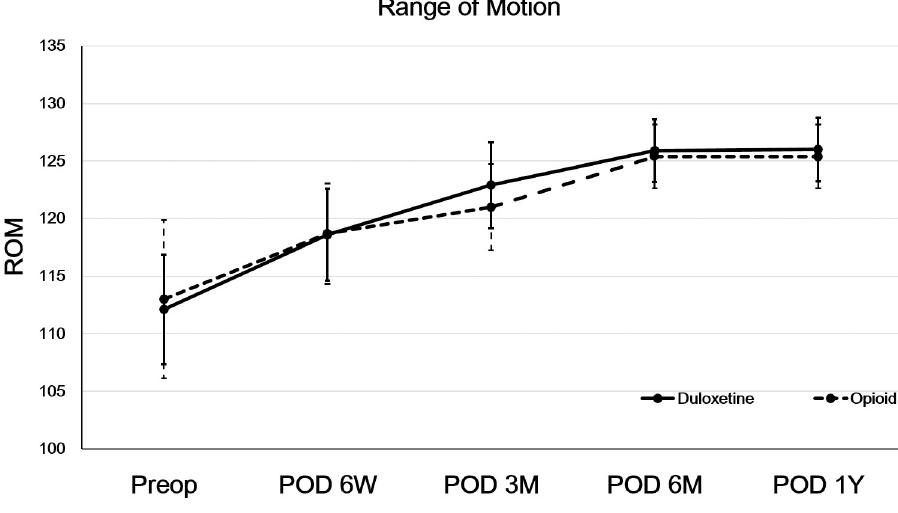
Fig 2. Comparisons of Range of Motion (ROM) between duloxetine and opioid groups. ROM did not differ between the two groups during postoperative period. Both groups showed significant improvement of ROM at 1 year postoperatively compared to the preoperative period ( p < 0.05). Error bars represent the standard deviation.